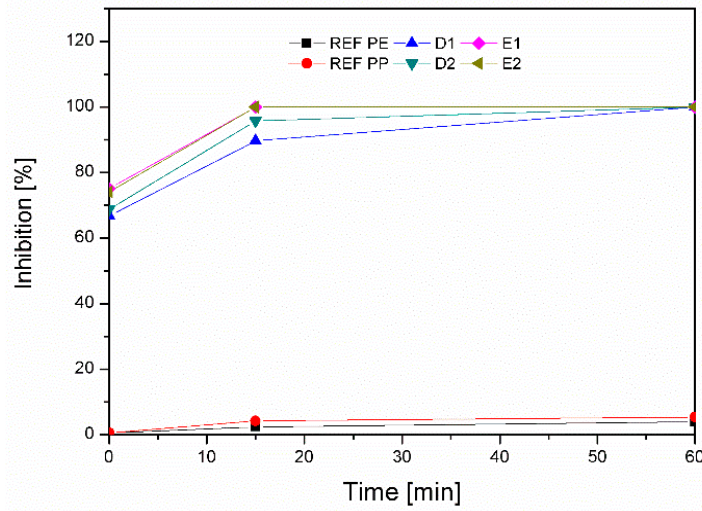
Figure 8. Graphical representation of anti-oxidative activity of CS, CSNPs RES-coated PE, and PP foils after the same time interval.